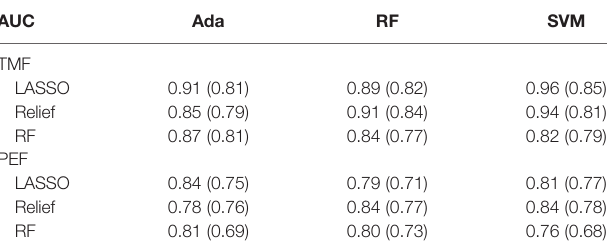
TABLE 4 | Comparison of predictive performance between radiomic model and neuroradiologists in the validation